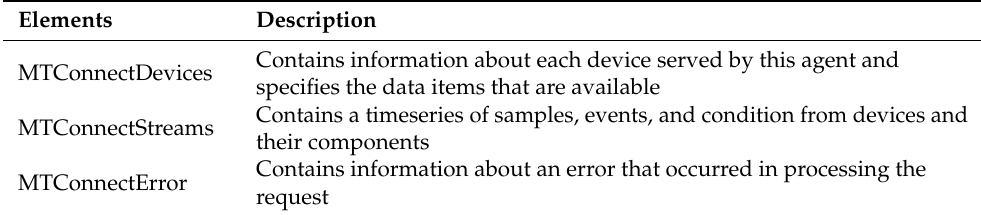
Table 3. MTConnect response XML